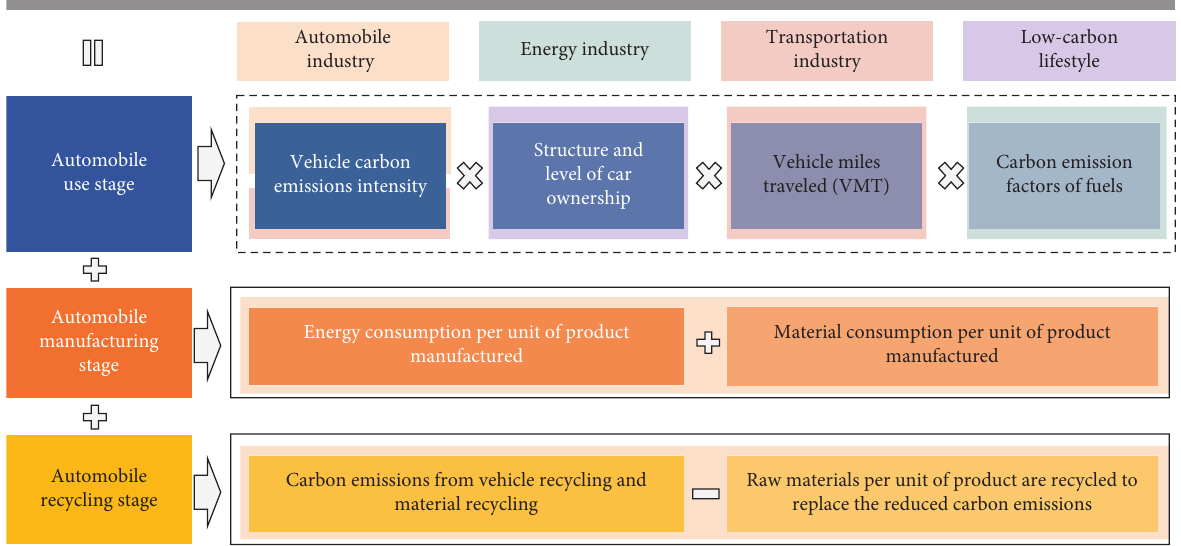
Figure 5: Identification of key factors affecting carbon emissions in the automobile industry.